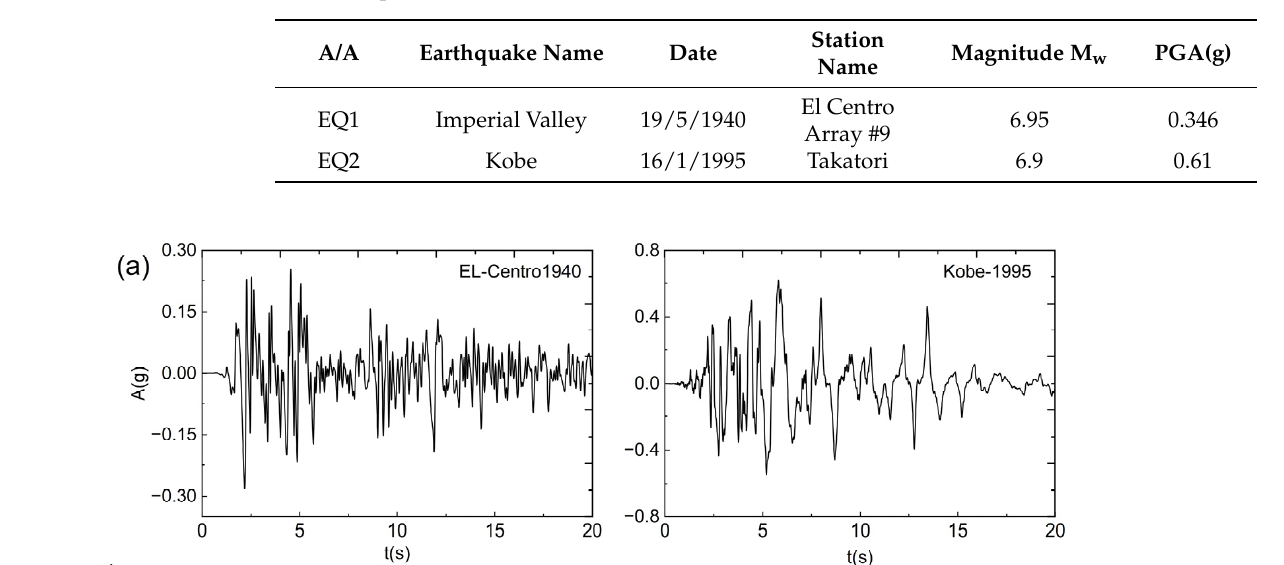
Table 8. Input seismic motion.